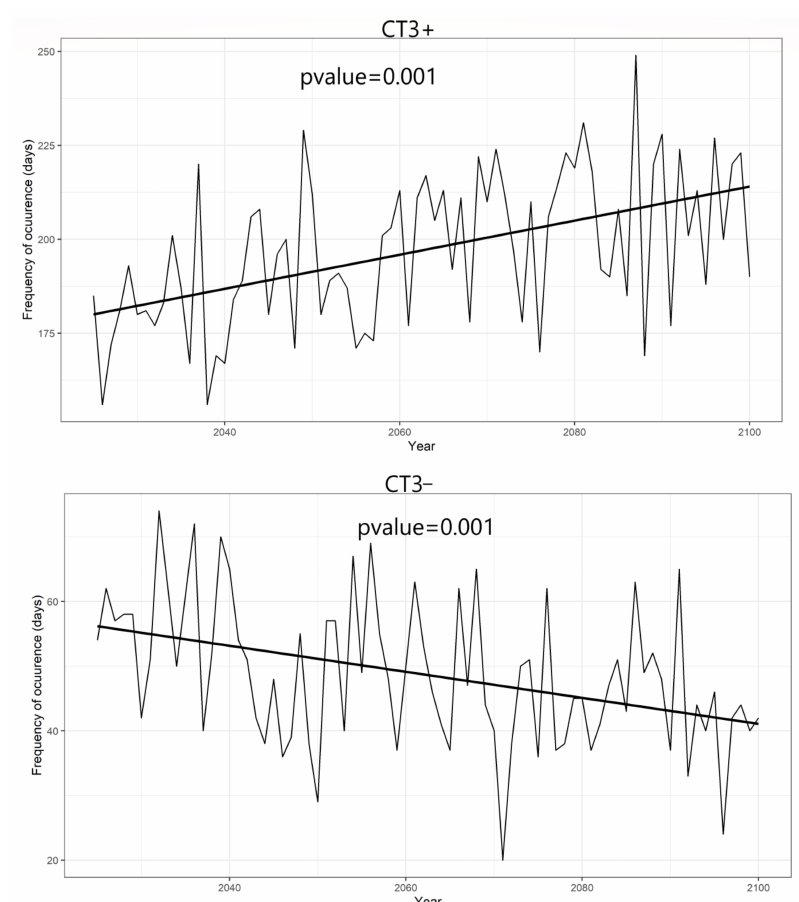
Figure A1. The trend in the annual frequency of occurrence of CT3+ and CT3 − exemplified from the high-resolution CMCC-CMS CMIP5 GCM, for the 2030–2100 period under the RCP8.5